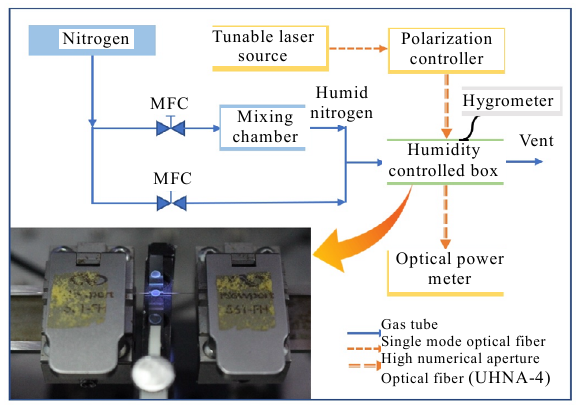
Fig. 1 Schematic diagram of the humidity sensing measurement system (inset) with the SnO 2 nanoparticle coated on the straight channel optical